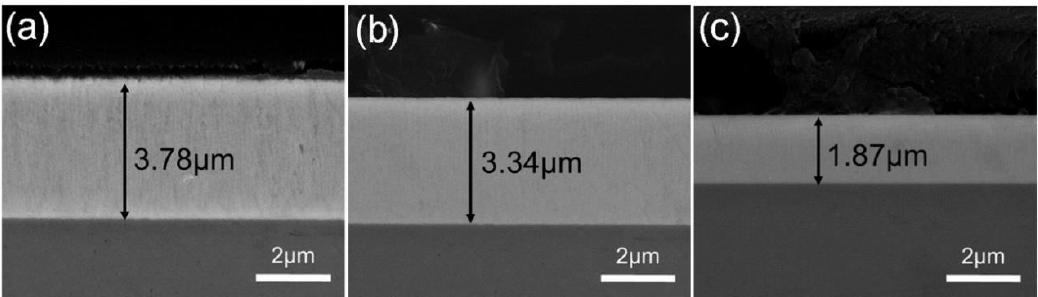
Figure 6. FESEM images of cross-sections of Ta coatings. ( a ) 200 °C-175 W, ( b ) 300 °C-150 W, and ( c ) 400 °C-100 W.